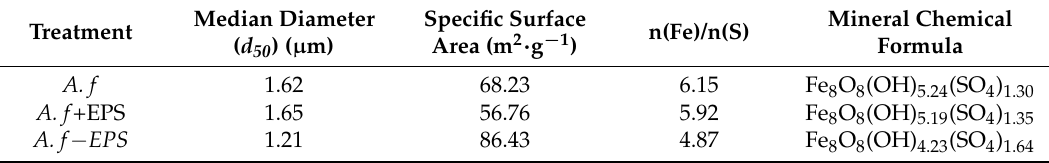
Table 1. Physicochemical properties of biosynthesized schwertmannite under different treatments at 28 °C and 180 rpm for 72 h: A. f , conventional A. ferrooxidans ; A. f +EPS, A. ferrooxidans with EPS exfoliated but not removed; A. f −EPS, A. ferrooxidans with EPS exfoliated and removed. Experimental